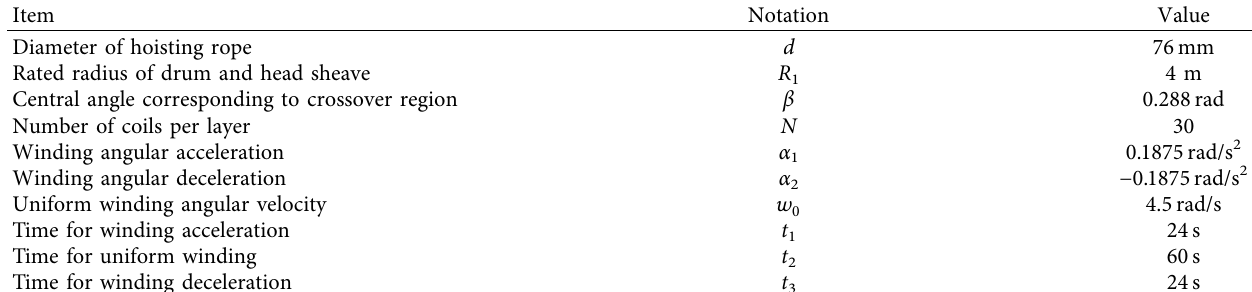
Table 1: Motion parameters of a superdeep mine hoist.